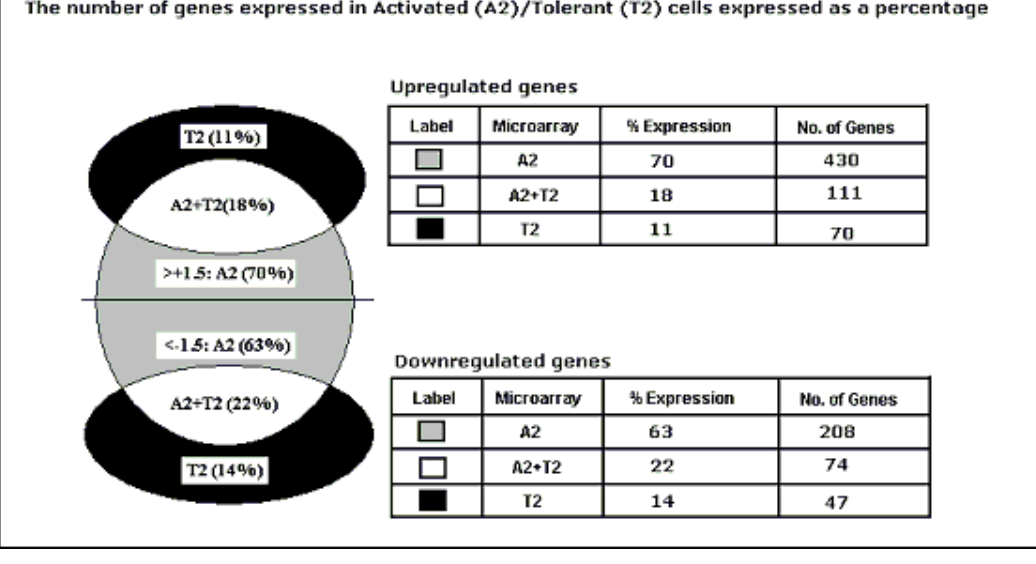
Figure 6. The number of genes expressed in Activated (A2)/Tolerant (T2) cells expressed as a percentage. A pictorial representation of Table 2, displaying the percentage of gene expression in up regulated and down regulated A2 and T2 cells. The percentage is calculated as the number of genes in each microarray divided by the total number of genes up regulated or down